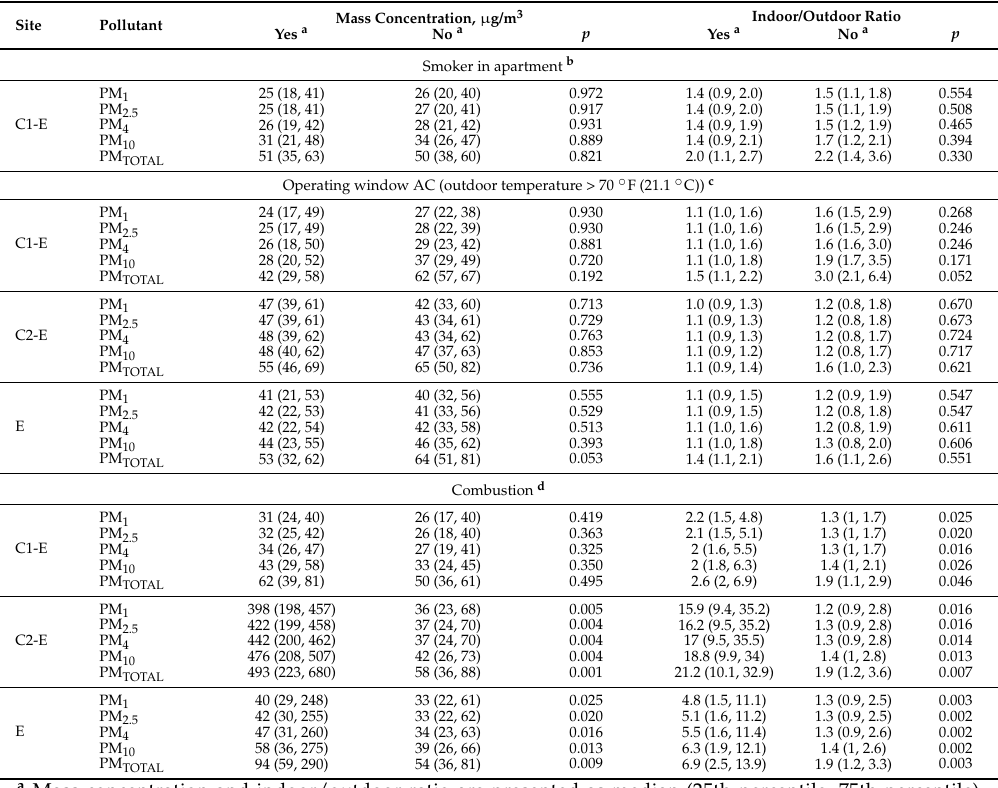
Table 2. Kruskal-Wallis tests for particulate mass ( µ g/m 3 ) and indoor/outdoor ratio by apartment smoking, air conditioning, and combustion.